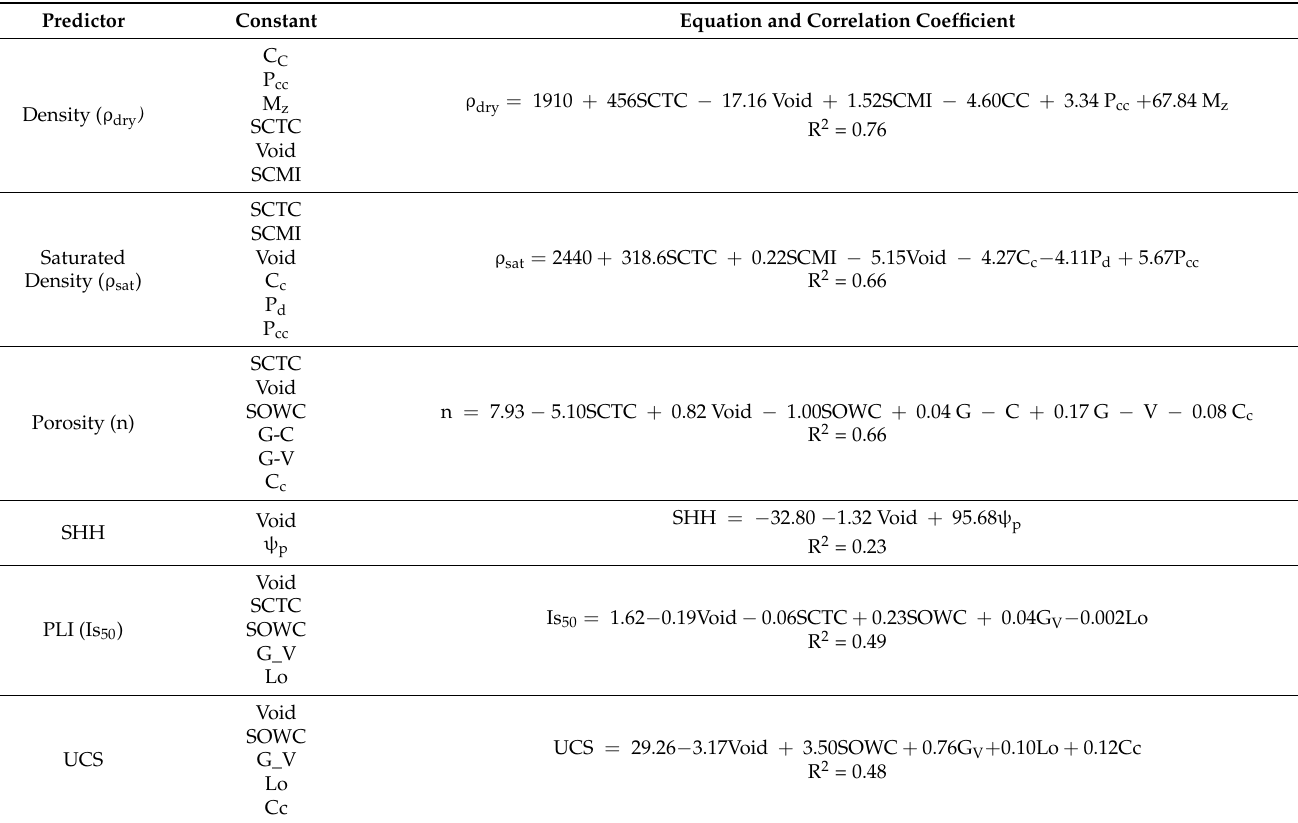
Table 17. Prediction model of multiple regression for physical and mechanical indexes [120] (SHH is Schmidt hammer hardness, UCS is uniaxial compressive strength in MPa, DOI is the degree of induration, PLI is point load index in Mpa, porosity is in %, G-C is in %, G-V is in %, Cc is in %, E s is Secant modulus in GPa, E t is the tangent modulus in GPa. P dry is dry density is in Kg/m 3 , and P sat is saturated density in Kg/m 3